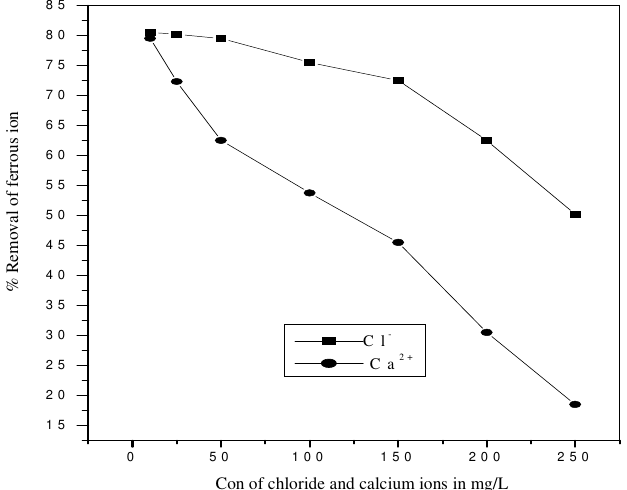
Figure 6. Effect of other ions on the adsorption of ferrous ion onto ZDC [M] = 15 mg/L; contact time = 60 min; adsorbent dose = 25 mg/50